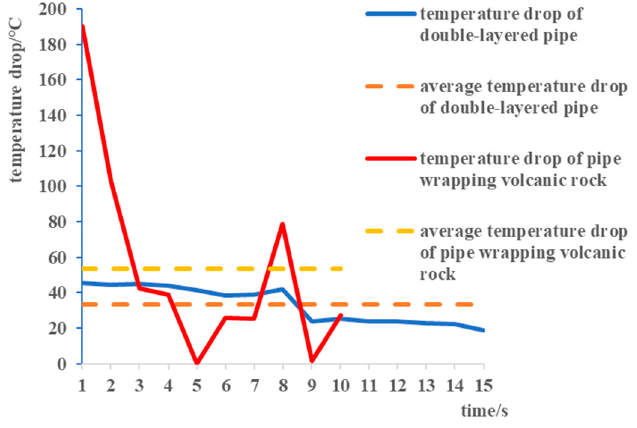
Figure 6. The temperature drop of exhaust pipe.